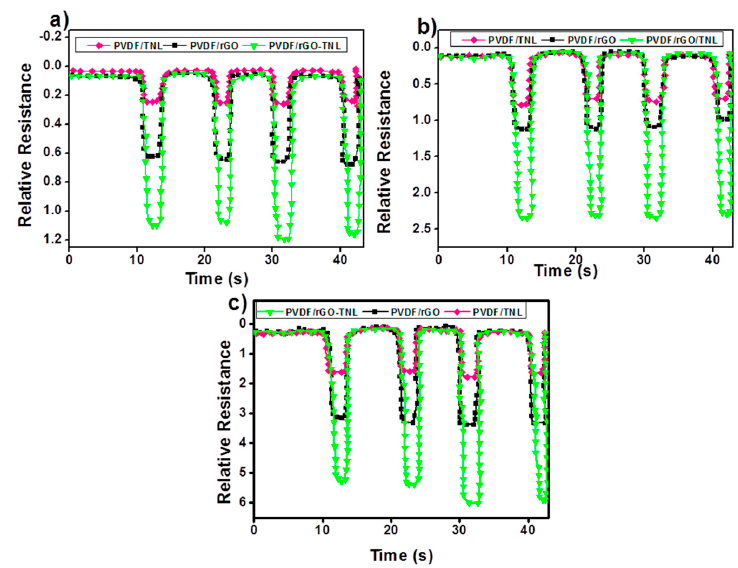
Figure 16. Sensing responses of PVDF/rGO, PVDF/TNL and PVDF/rGO-TNL composites to: ( a ) 5 kPa; ( b ) 10.7 kPa; and ( c ) 17.6 kPa.